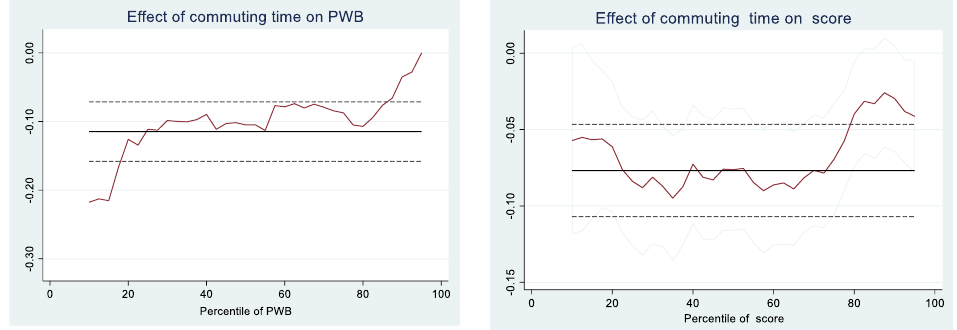
Figure 1. Censored Quantile Estimates.